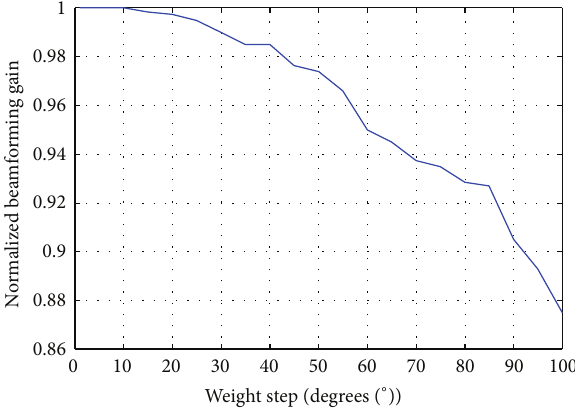
Figure 7: Normalized beamforming gain versus weighting step.